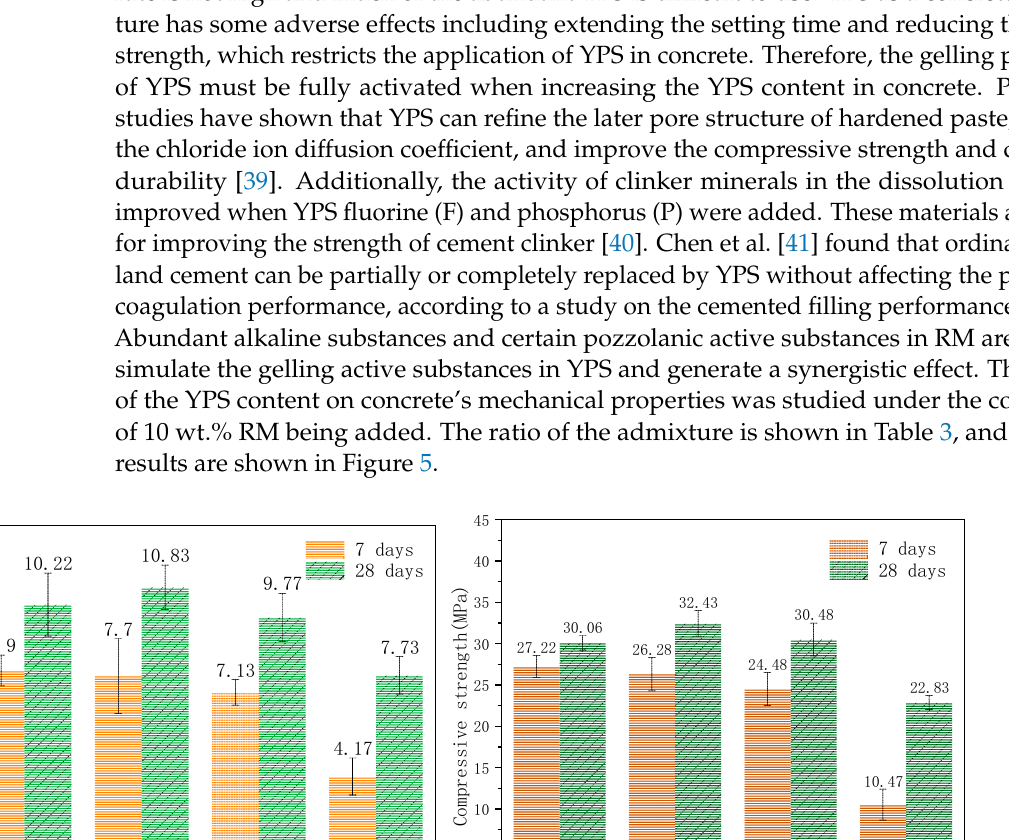
Figure 4. The curve of ( a ) flexural strength and ( b ) compressive strength of concrete prepared with RM par ‐ tially substituting ordinary Portland cement.